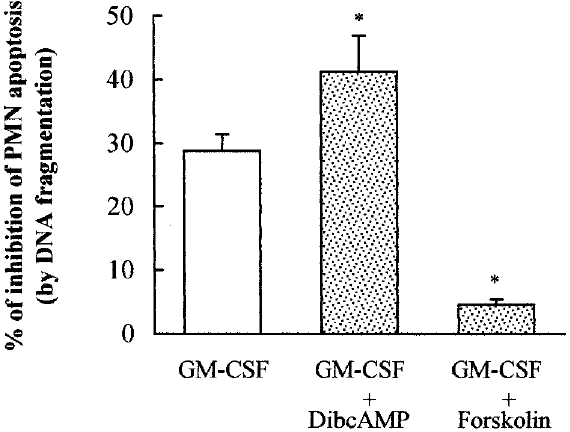
FIG. 3. Modulating effects of cAMP-elevating agents on GM- CSF-mediated inhibition of Fas-induced neutrophil apoptotic death. PMN were pretreated for 2h with GM-CSF (1000UI/ ml), either used alone (white column) or in combination with dibutyryl cAMP (2 3 10 –3 M) or forskolin (10 –4 M) (dotted columns), before the addition ofmAb CH-11 (150ng/ml). After a 12h culture, cells were recovered and further processed for DNA fragmentation analysis. Results are expressed as percentage of inhibition (mean±SD) of low to high molecular weight DNA ratio induced by the various substances in 12 independent donors. Significance versus homologous cells suspensions treated with GM-CSF only: * p